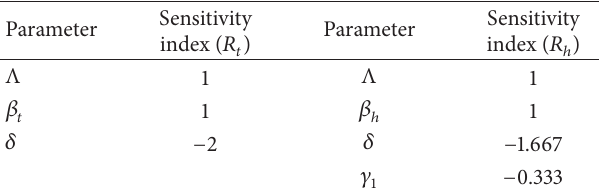
Table 2: Sensitivity indices to parameter for the TB-HIV model.